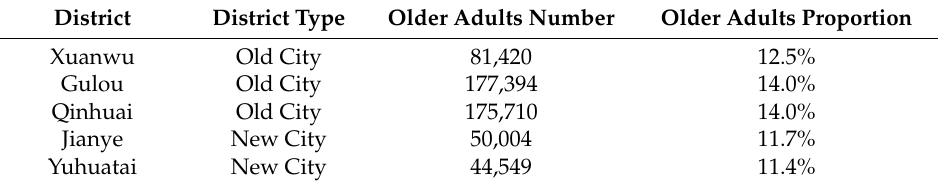
Table 9. Distributions of the elderly populations in each district